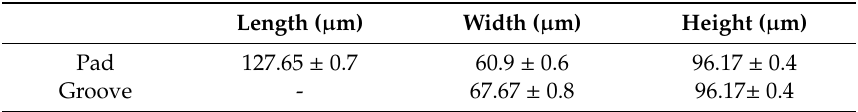
Figure 6. Images of surface topology of non-textured ( A ) and textured prototype pin ( B ) under 30° angle of vision captured with confocal laser scanning microscopy. The spatial surface topology is shown in ( C ) whereby the white dashed box in ( B ) shows the position of the scan. Table 3. Geometric dimensions of the prototype pin surface measured with confocal laser scanning microscopy (Figure 6).